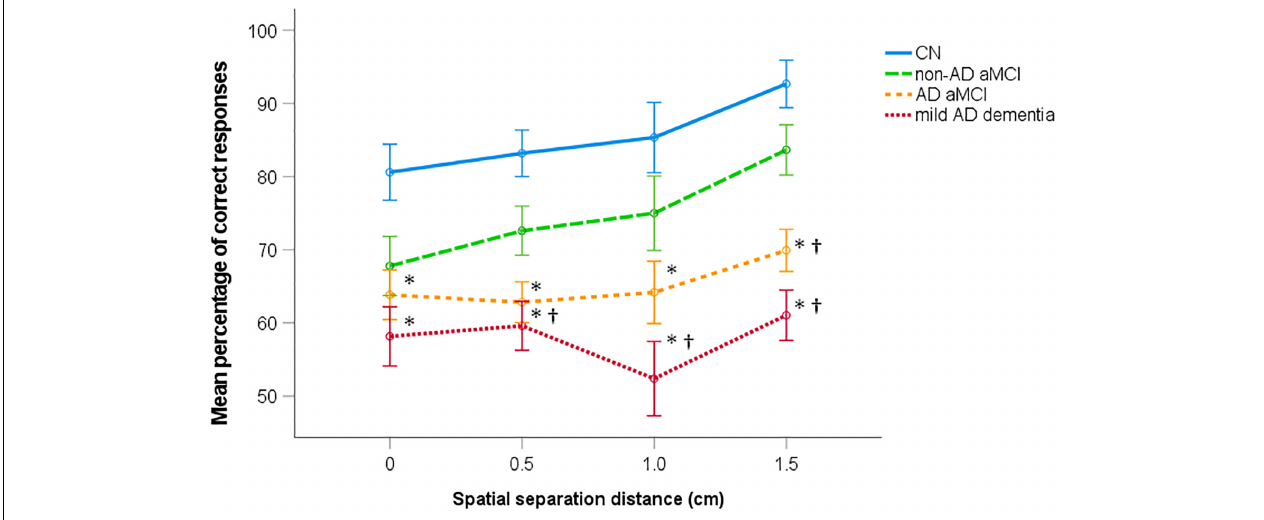
FIGURE 3 | Spatial pattern separation performance. Mean percentage of correct performance for each spatial separation ( ± 1 SE). ∗ p < 0.05 compared to the CN group; † p < 0.05 compared to the non-AD aMCI group. CN, cognitively normal; non-AD aMCI, amnestic mild cognitive impairment with non-Alzheimer’s